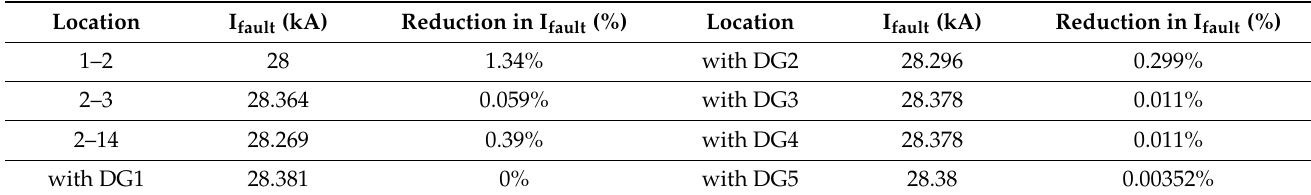
Table 3. Fault current at different locations (8.26 × 10 6 per unit FCL).